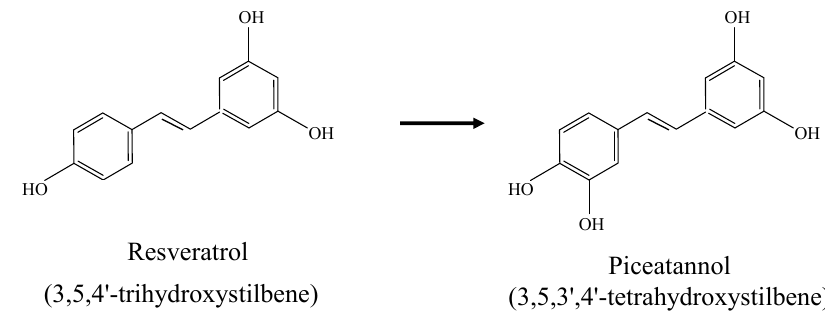
Figure 1. Molecular structures of trans-resveratrol and piceatannol. The conversion of trans -resveratrol to piceatannol is catalyzed by Streptomyces sp. Strain SB-14.